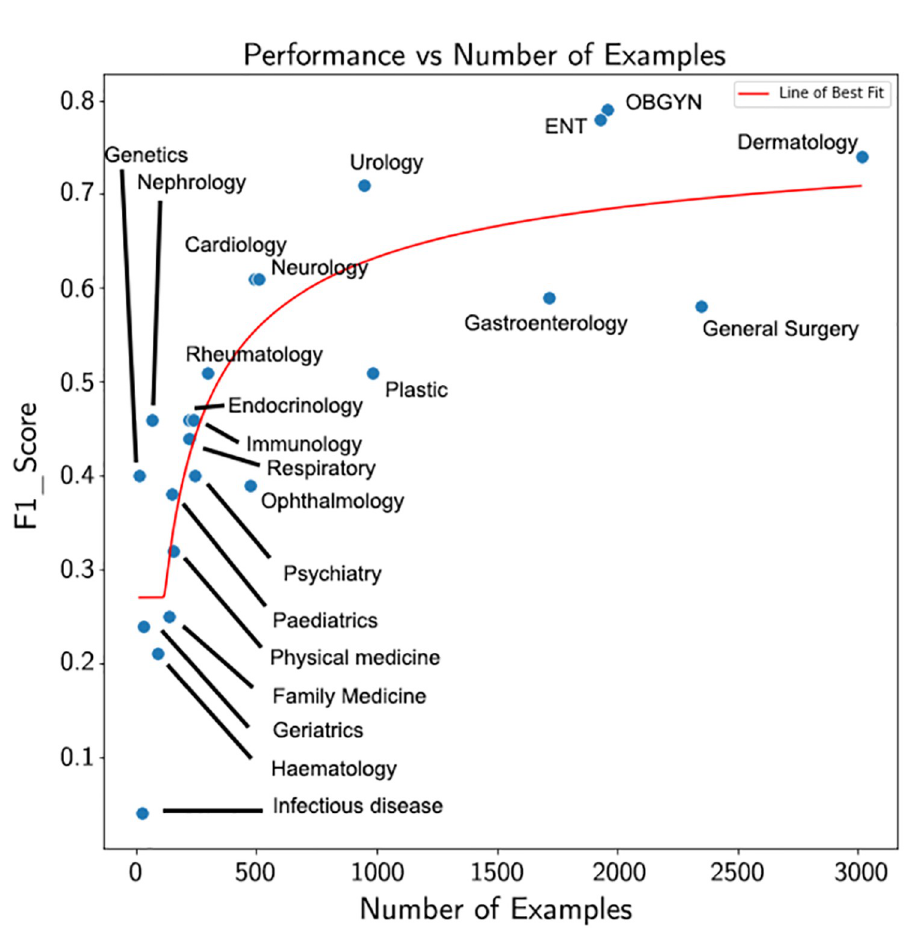
Fig 2. The F 1 Score as a function of the number of training examples. In this figure we present the F 1 score from the model with the highest F 1 score for each specialty (the last column of Table 3) against the number of training (Table